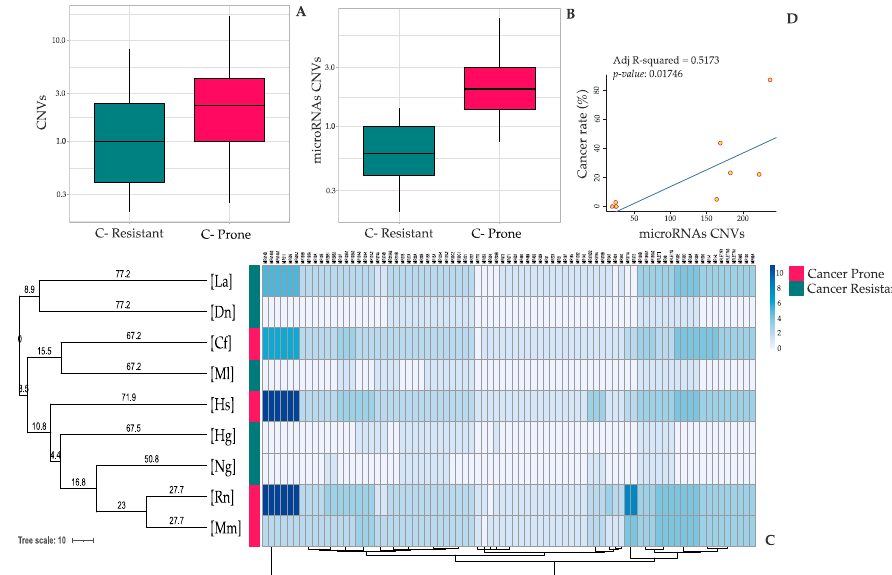
Figure 1. CNV landscape comparisons: ( A ) Boxplot of the distribution of significant gene CNVs in cancer-prone vs. cancer-resistant species. ( B ) Boxplot of the distribution of significant microRNA CNVs in cancer-prone vs. cancer-resistant species. Cancer-resistant species are highlighted in green, cancer-prone species in red. In the boxplots, the Y -axis scale has been changed to log one. The boxplots were built considering the average number of copies of each gene in the two different target groups. ( C ) Heatmap representing the microRNA CNV repertoires within the nine analyzed species—(Hg): Heterocephalus glaber ; (Ng): Nannospalax galili ; (Dn): Dasypus novemcinctus ; (La): Loxodonta Africana ; (Ml): Myotis lucifugus ; (Mm): Mus musculus ; (Rn): Rattus norvegicus ; (Cf): Canis familiaris ; (Hs): Homo sapiens . Hg, Ng, Dn, La and Ml have been previously described as cancer-resistant species. Mm, Rn, Cf and Hs are known to be cancer-prone species. Phylogeny was inferred from VertLife [35], created and visualized through the Interactive Tree of Life web-tool [36]. ( D ) PGLS correlating the cancer incidence rate with the total number of significant microRNAs copies across the nine species included in the analysis. The blue line represents a positive correlation between the two variables (adjusted R 2 = 0.5173; p -value =